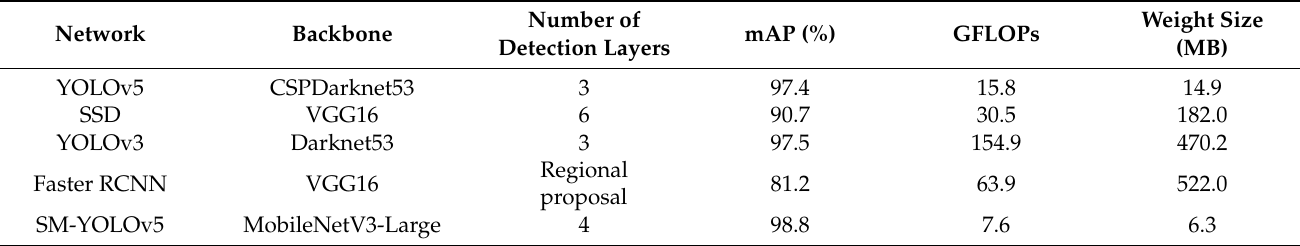
Table 5. Comparison of training and validation results for YOLOv5, SSD, YOLOv3, Faster RCNN, and